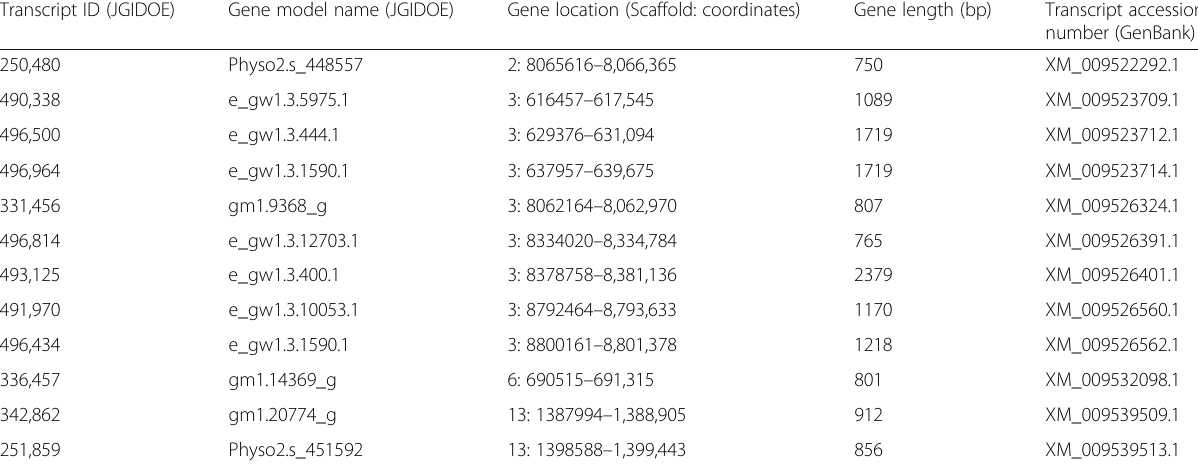
Table 1 The updated PL3-coding gene complement in P. sojae genome Transcript ID (JGIDOE) Gene model name (JGIDOE) Gene location (Scaffold: